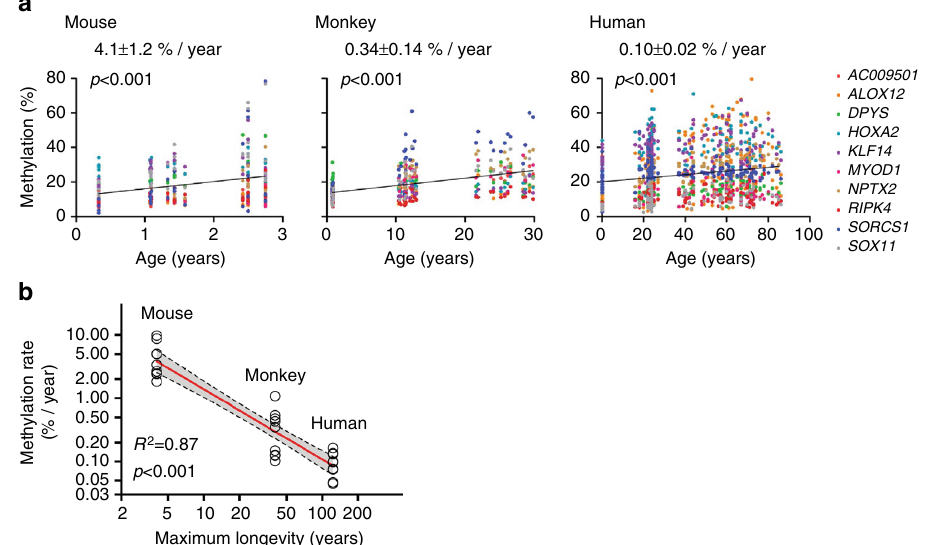
Fig. 3 Cross-species comparison of aging drift. a The association between age ( x axis) and methylation percentage of 10 hypermethylated ARM genes ( y axis) homologous in each species. Dots represent methylation values at 10 genes in each individual (mouse; young, n = 6, middle, n = 13, old, n = 12, monkey; infant, n = 12, middle, n = 15, old, n = 12, human; newborn, n = 13, young, n = 54, middle, n = 27, old, n = 45). p -values of the linear regression slope were calculated by t -test (two-tailed). b The association between methylation drift rate and lifespan. The x axis represents maximum longevity of each species (mouse; 4 years, monkey; 40 years, human; 122.5 years), and the y axis represents methylation changes per year. The scales are logarithmic. The maximum longevities of the three species were obtained from The Animal Ageing and Longevity Database (http://genomics.senescence.info/species/). The R -squared values and their p - values ( F -test, two-tailed) were